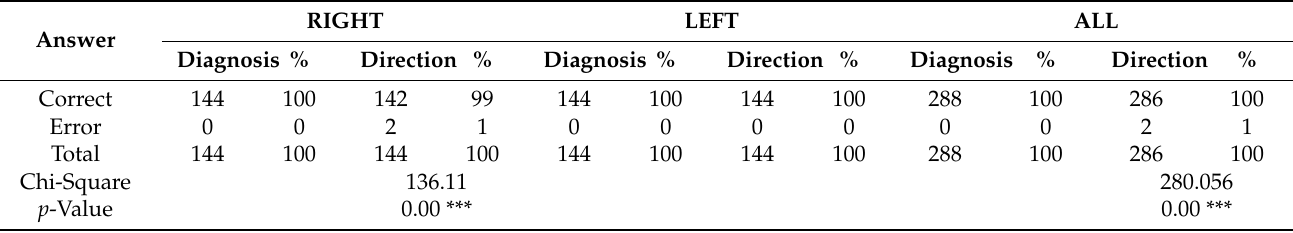
Table 5. Validity of OCI at Grade III (4 ◦